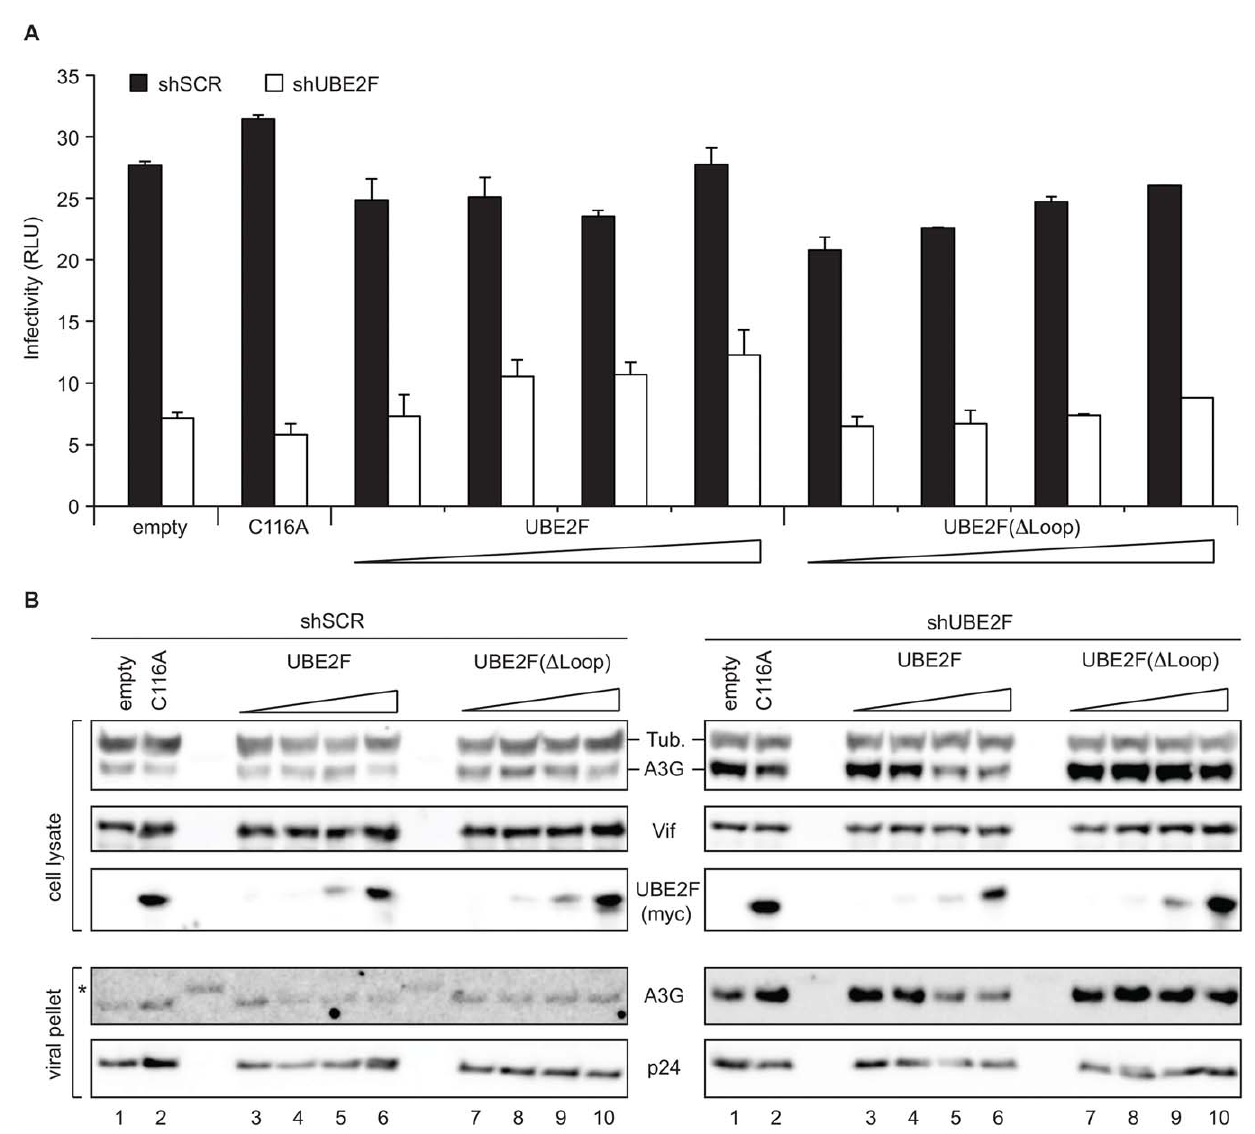
Figure 6. The UBE2F loop insertion is required for efficient viral infectivity. A, Single-cycle infectivity assay of HIV NL4-3 D Vif produced from HEK293T cells stably depleted for UBE2F (white bars), or non-silencing control shRNA (black bars) in the presence of transfected HIV NL4-3 D Vif (1 m g), A3G-V5 (500 ng), Vif-FLAG (100 ng), and increasing amounts of RNAi-immune wild-type or D Loop UBE2F-myc (0.2, 1, 3 or 10 ng), a catalytic mutant of UBE2F harboring a cysteine to alanine change at position 116 (10 ng), or empty vector control (10 ng). Mean and + -SD of duplicate experiments are graphed. B, Immunoblots of cell lysates and virus particles corresponding to panel A . A3G levels in cellular lysates and virus particles in UBE2F KD cells transfected with increasing amounts of RNAi-immune UBE2F (compare lanes 3–6, left and right), catalytic mutant UBE2F (C116A) or increasing amounts of UBE2F ( D Loop) (lanes 1, 2, 7–10 left and right). To discern A3G levels in the virion in the shSCR lanes the immnoblots were exposed longer and non-specific bands from the protein ladder became apparent, as indicated by an